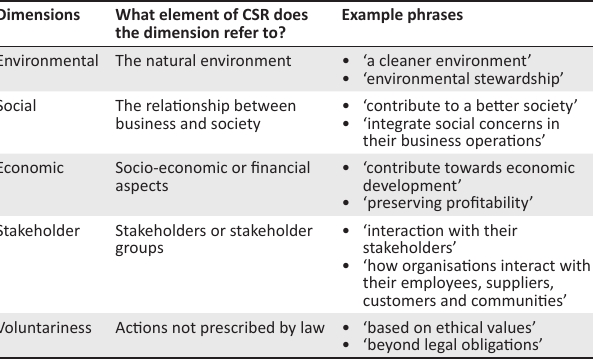
TABLE 1: Dahlsrud’s five dimensions of corporate social